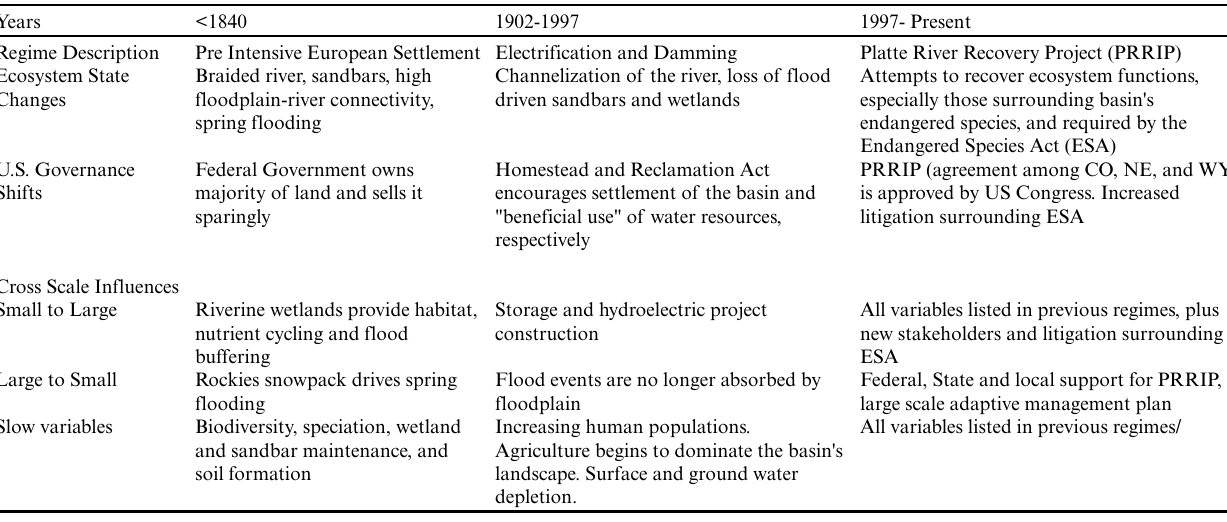
Table 8 . Resilience Assessment of Historical Changes in the Platte River Basin. Extending across portions of northeast Colorado, southeast Wyoming and central Nebraska, the social-ecological system of the Platte River Basin has undergone a series of transformations during the 19th and 20th century. Each transformation reflects a shift in the ecological components, social components and/or governance regimes. We describe three regimes, each of which were partially triggered by changes in system governance, with direct and indirect consequences for interactions among social-ecological components of the